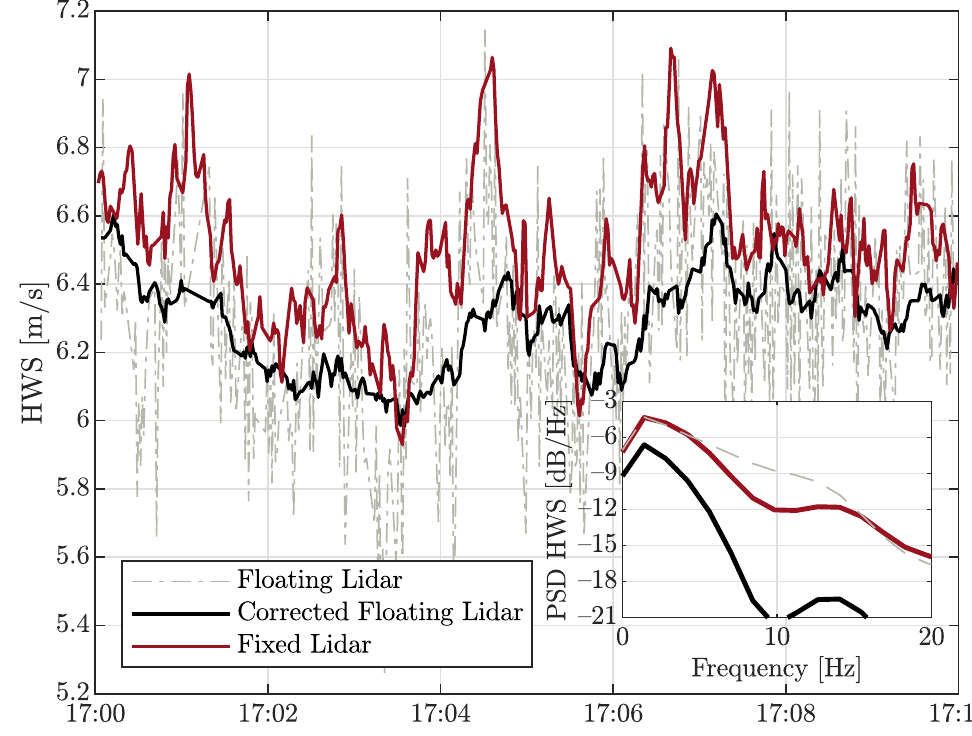
Figure 9. Same as Figure 8. High HWS-variance scenario (22 June 2013, PdP). Overall campaign analysis.- With a view to assess the overall filter performance, the TIs measured by the FDWL during the PdP campaign (25 days, 1875 records) with and without correction ( TI float ., corr . and TI float . , respectively) were compared to the TI measured by the fixed LiDAR ( TI fixed ). In the context of WE, the typical temporal resolution of wind- related data products is 10 min; thus, the comparison was carried out at 10 min temporal resolution. To carry out this comparison, different statistical indicators were